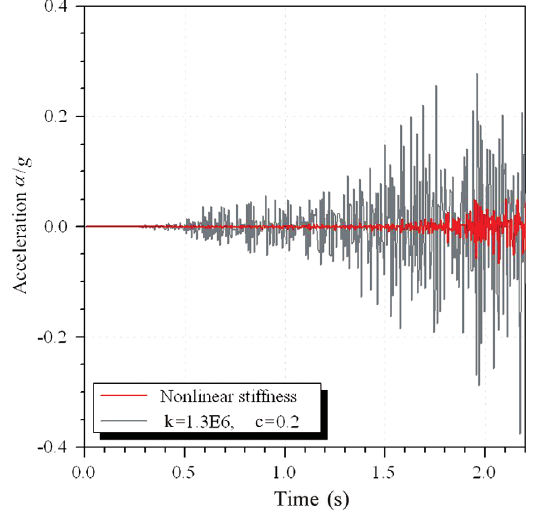
Figure 8: Acceleration of the capital for linearly and non-linearly isolated columns.